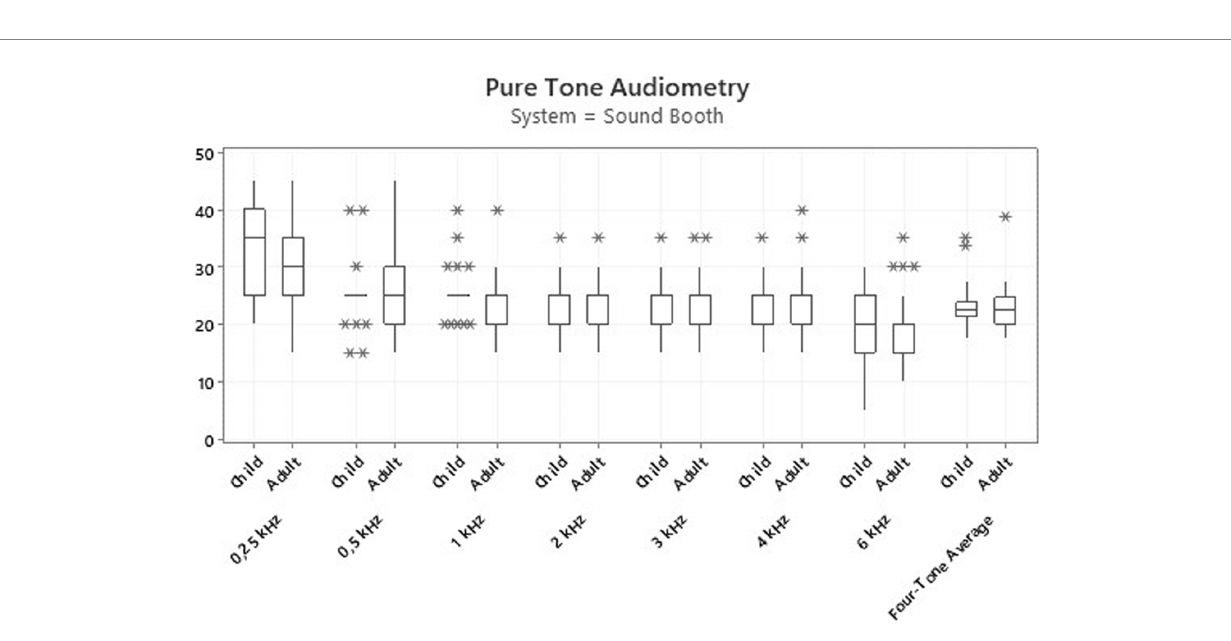
FIGURE 4 Thresholds for the PTA assessment with the CLABOX. The results were not statistically significant at all frequencies evaluated. The box plot represents the 25th and 75th percentiles (box boundaries) and medians (horizontal lines). Outliers are indicated with